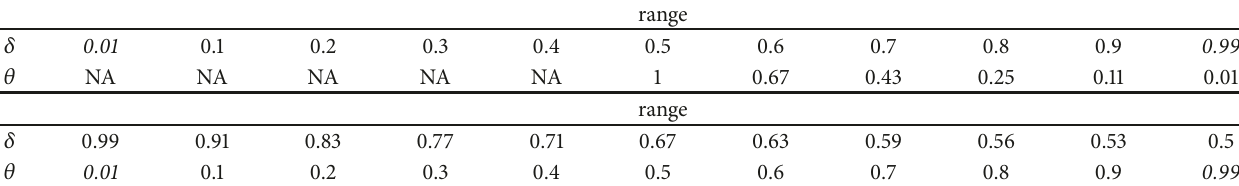
Table 2: Expected minimum profit under different unit cost of TA.